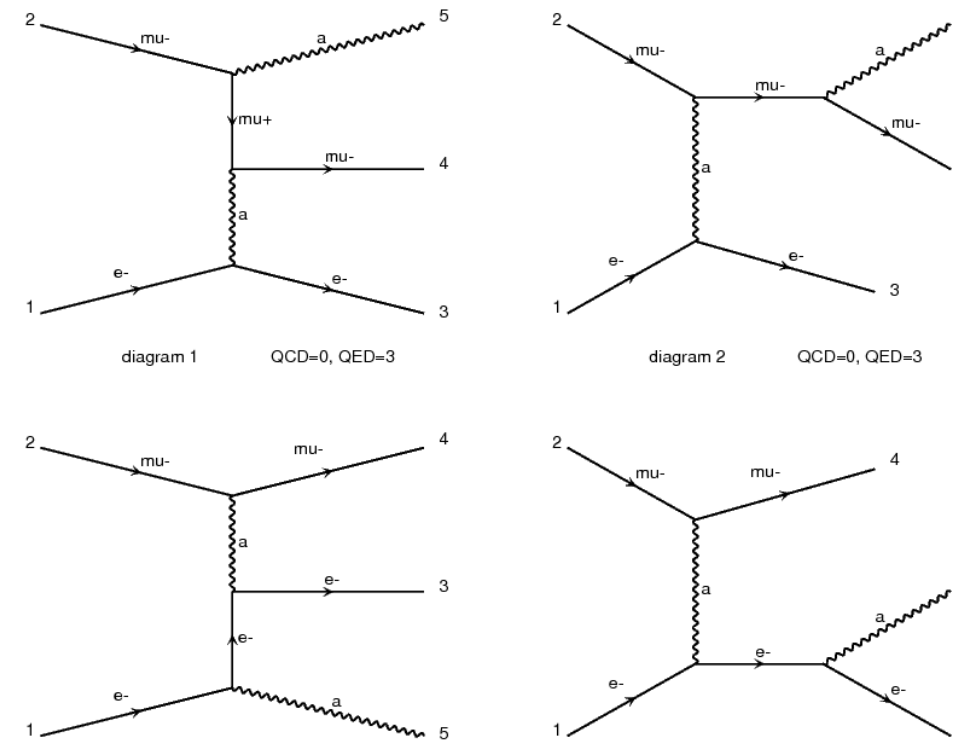
Figure 2 . Real-emission diagrams relevant to the process e(cid:22) ! e(cid:22)(cid:13)